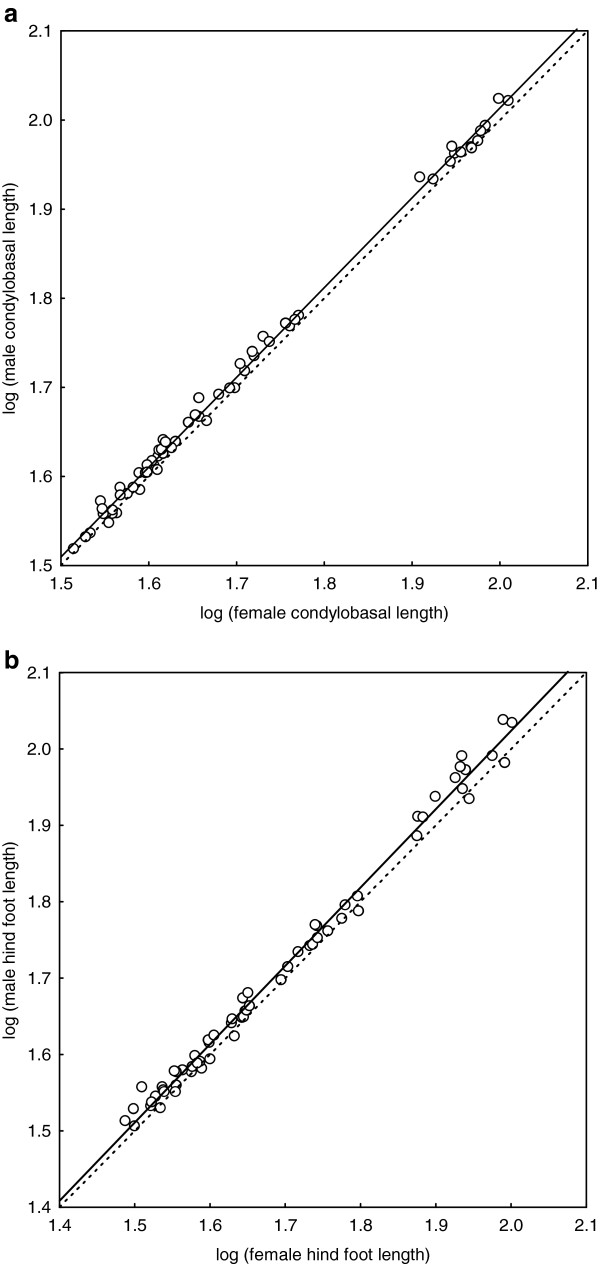
Mean male body size increases isometrically with mean female body size among species of ground squirrels. a) condylobasal length, b) hind foot length. Ordinary least-square regression (solid lines) and 1:1 relationship (dashed lines) are shown.